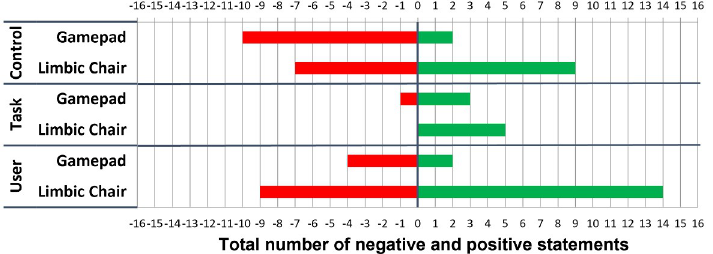
Fig 10. The content analysis of Experiment 2. The total numbers of negative (red) and positive (green) statements are shown on the horizontal axis and encoded in three categories (Control, Task, and User) and for each control interface (vertical